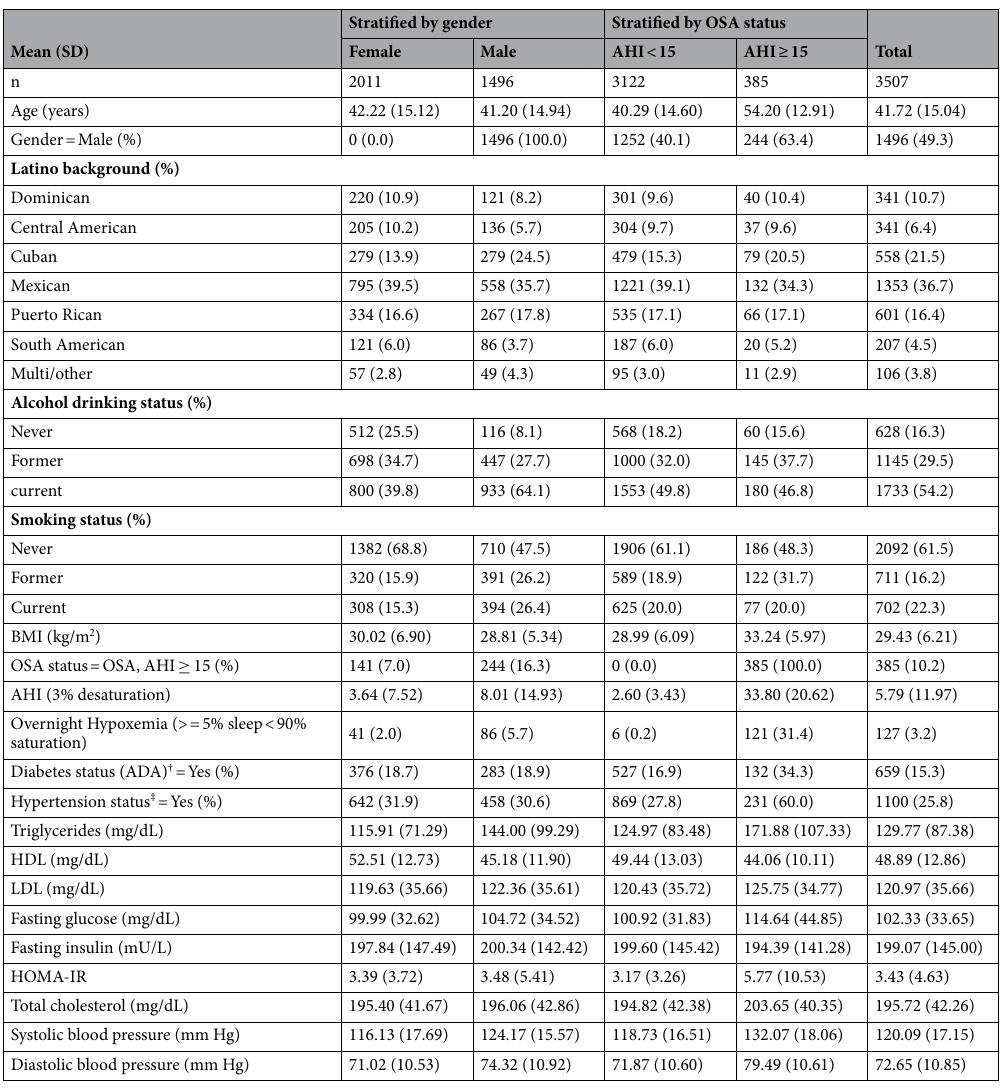
Table 1. Characteristics of Hispanics/Latinos represented by the HCHS/SOL study population. *Means and percentages were weighted using sampling weights to provides estimates of the HCHS/SOL target population characteristics. † Baseline diabetes are based on American Diabetes Association definition (Diabetes Care 2010;33:S62-69), defined as fasting glucose ≥ 100 mg/dL, or post-OGTT glucose ≥ 140 mg/dL or A1C ≥ 5.7%, or use of anti-diabetic medication. ‡ Baseline hypertension is defined as systolic or diastolic BP greater than or equal to 140/90 respectively, or current use of antihypertensive